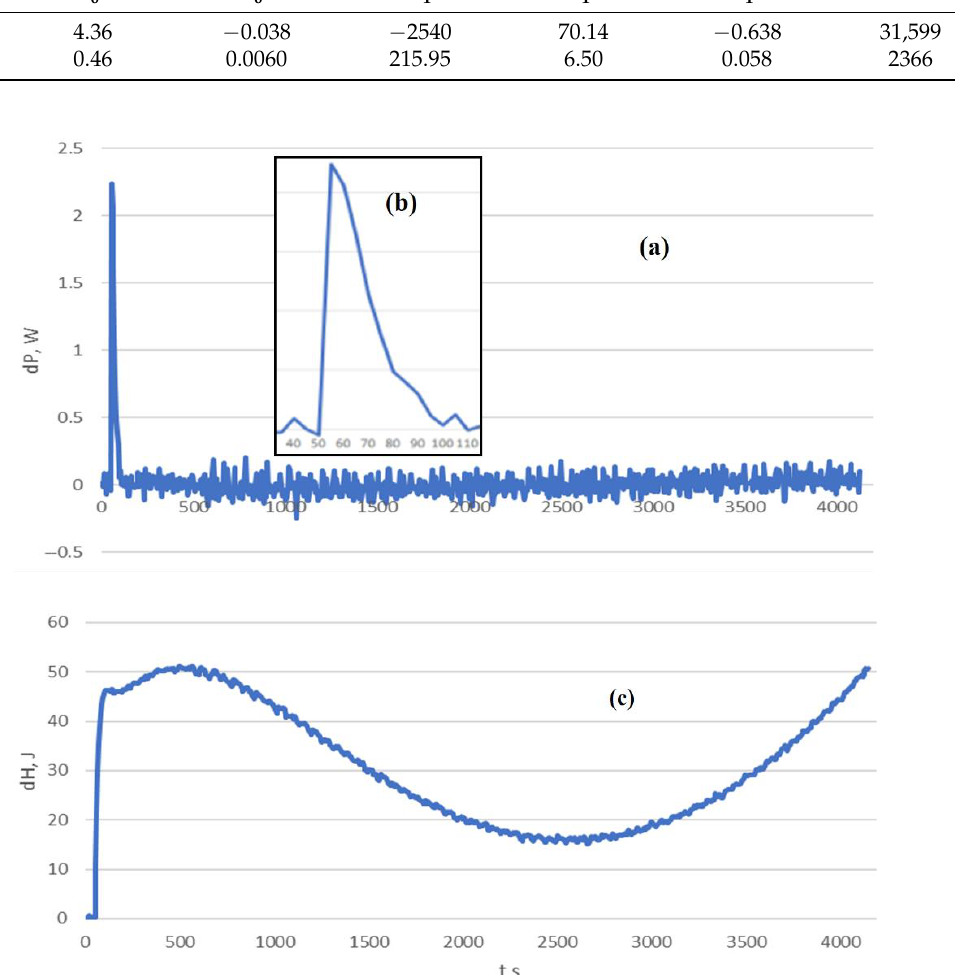
Figure 6. Residual power ( a ) with detailed view ( b ) and enthalpy ( c ) for Equation (4) with coefficients from Table 3.